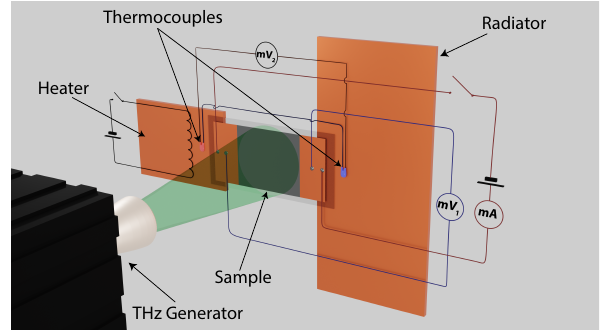
Figure 1. Schematic view of the experimental